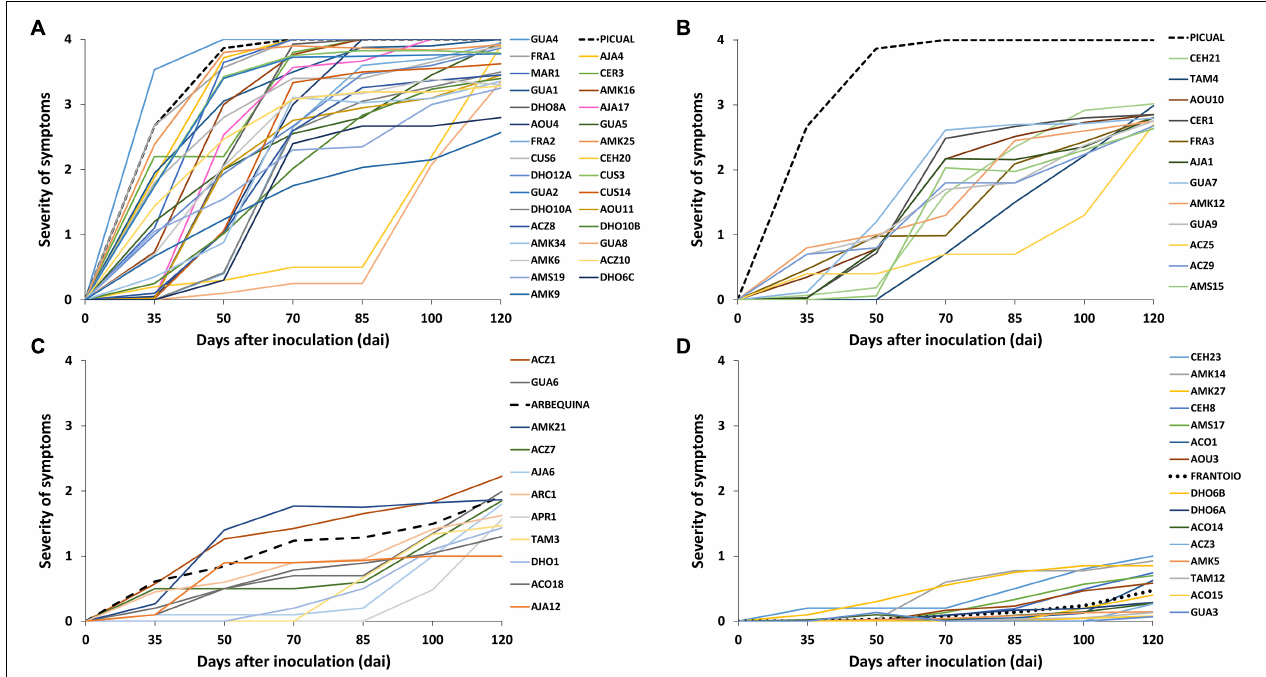
FIGURE 1 | Progress of the severity of symptoms recorded in wild olive genotypes inoculated with the defoliating isolate VD117 of Verticillium dahliae (assays 1–4). Values are the means of 24 plants per assay. Severity of symptoms was assessed each time on a 0–4 rating scale according to the percentage of Maximum Intensity Symptoms ( MIS ): chlorosis, leaf and shoot necrosis or defoliation: 0 = 0% MIS or no symptoms; 1 = 25% MIS ; 2 = 50% MIS ; 3 = 75% MIS ; 4 = 100% MIS or dead plants. (A) extremely susceptible, (B) susceptible, (C) moderately susceptible, and (D) resistant genotypes. The extremely susceptible cultivar Picual was maintained in panel 1B as a reference. Reference control cultivars Picual, Arbequina, and Frantoio are indicated in dashed